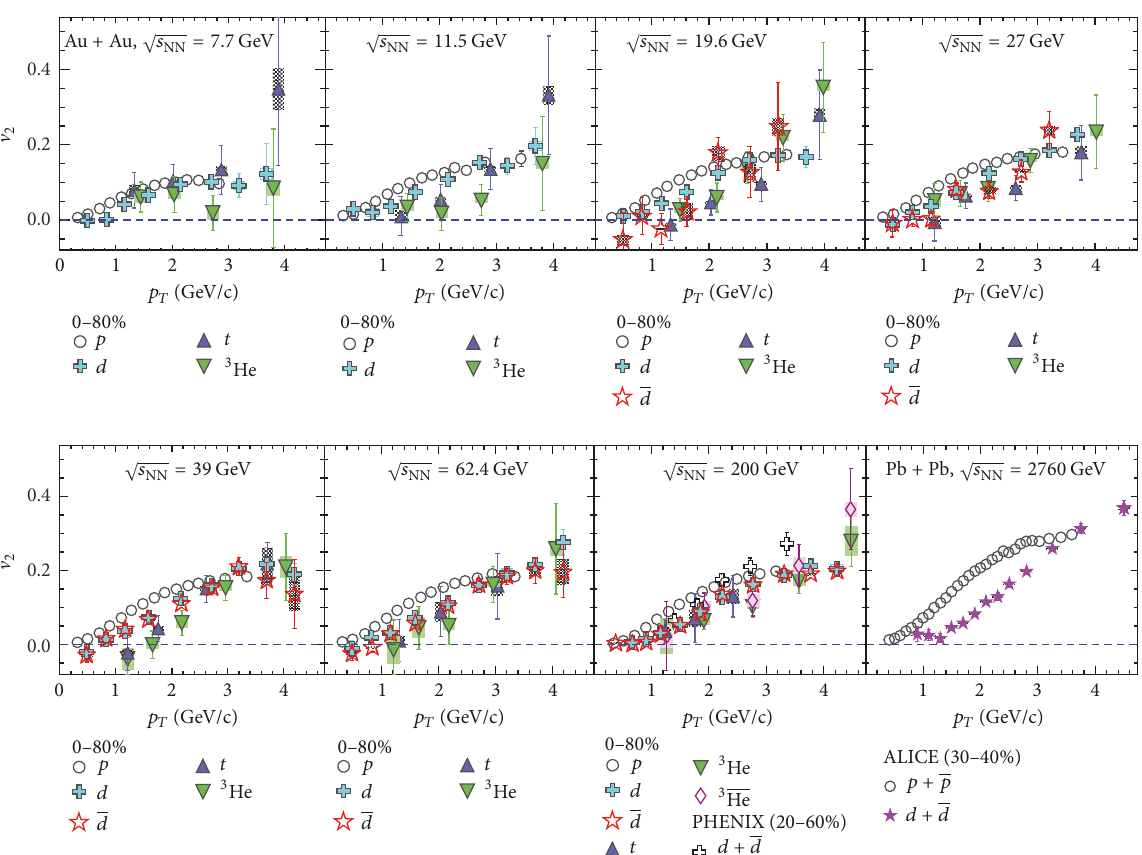
Figure 1: Midrapidity V 2 (𝑝 𝑇 ) for light nuclei ( 𝑑 , 𝑑 , 𝑡 , 3 He, and 3 He) in 0–80%, 20–60%, and 30–40% centrality from STAR, PHENIX, and ALICE, respectively. Proton V 2 (𝑝 𝑇 ) is also shown as open circles [41–44, 75] for comparison. Lines and boxes at each marker corresponds to statistical and systematic errors,